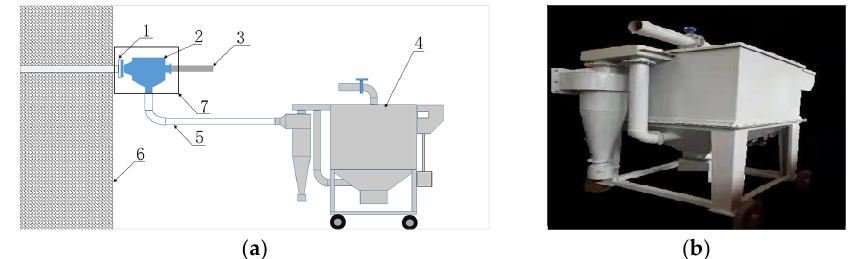
Figure 3. Dust control system for directional drilling in SBCS: ( a ) structure chart. 1—pre-embedded extraction pipe; 2—dust hood; 3—drill pipe; 4—dry dust collector; 5—dust collection pipeline; 6—coal mass; 7—dust control system in drilling; ( b ) real product.